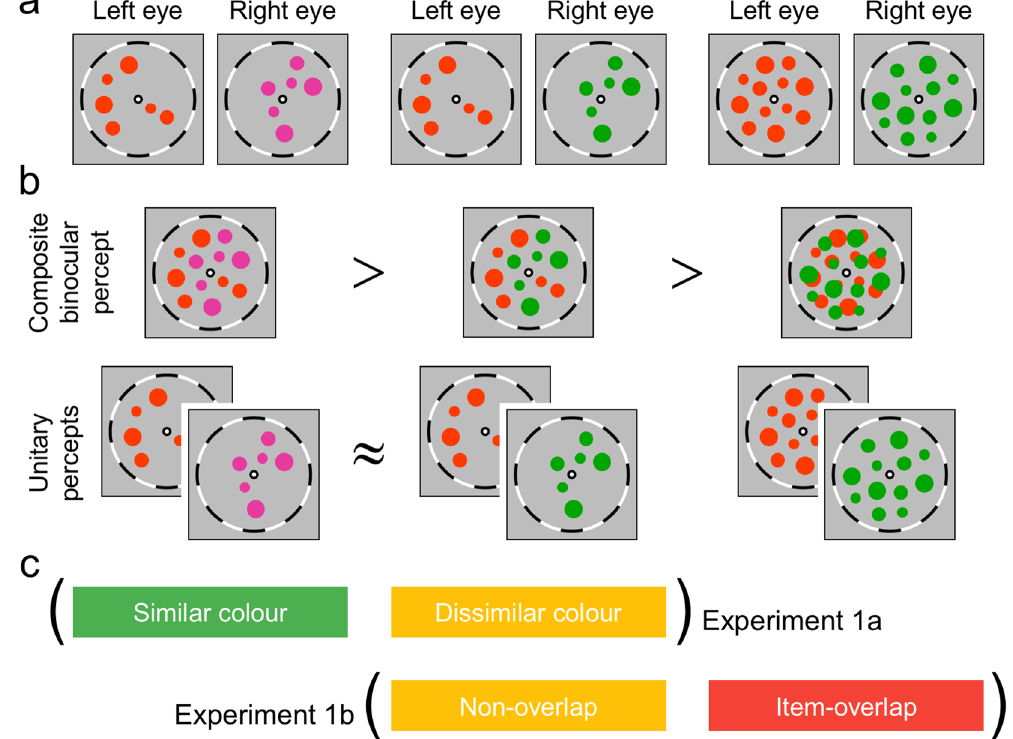
Figure 1. Conceptual examples of dichoptic stimulus arrays are shown in ( a ). For the presentation purpose, coloured circles are drawn in relatively bigger sizes compared to the bulls-eye fixation points and fusion frames. These dichoptic arrays produced different binocular ensembles depending on perceptual experience (composite binocular percept or unitary percept) and experimental manipulations ( b ). Superimposed images are shown as an ideal situation of composite binocular percept. Inequality and approximate equality signs in ( b ) depict our predictions on the stability of non-unitary/unitary percept. Composite binocular perception (CBP) would be more stable if it comprises similar colour circles rather than dissimilar colour circles. The latter CBP may indicate unsuccessful binocular matches. During binocular rivalry, however, unitary percepts to either left- or right-eye arrays would comprise the same colour items, and thus their stability would be similar. The colour similarity between dichoptic stimulus arrays (left and middle columns) and non-overlap vs. item overlap (middle and right columns) were manipulated and tested independently in Experiments 1a and 1b ( c